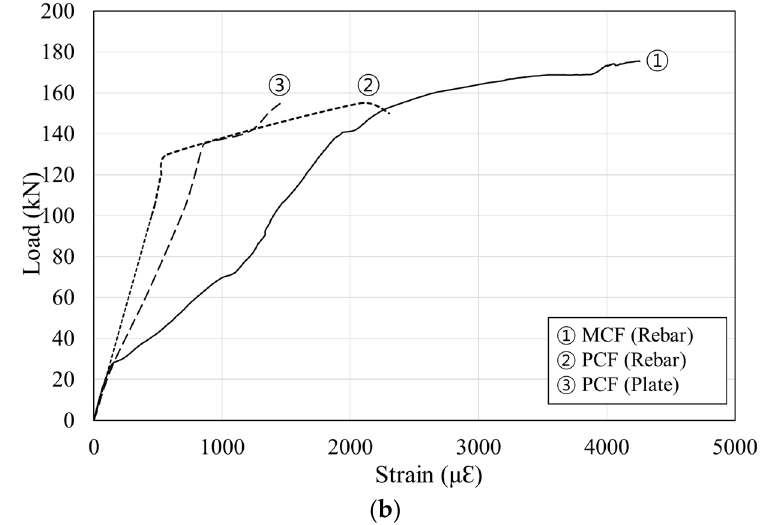
Figure 12. Strains of flexural test specimens: ( a ) strain of concrete; ( b ) strain of rebars and plate. To evaluate the shear behavior, the strain of the stirrup was analyzed as shown in